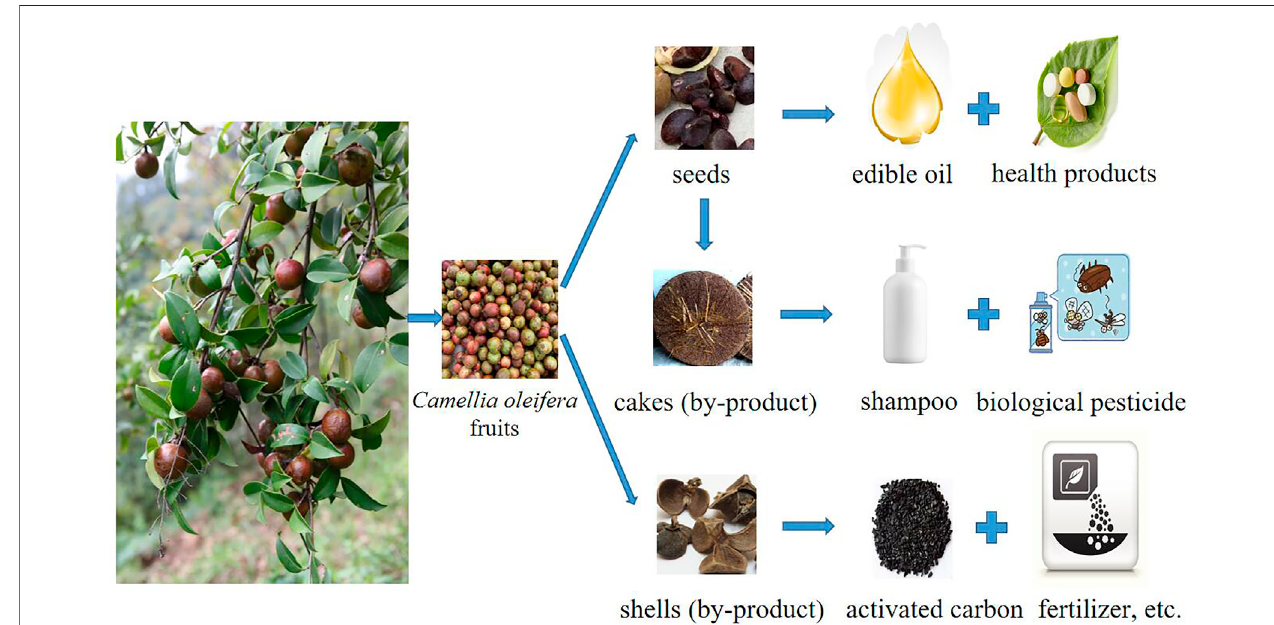
FIGURE 2 | Diagram illustrating the various industrial uses of C. oleifera